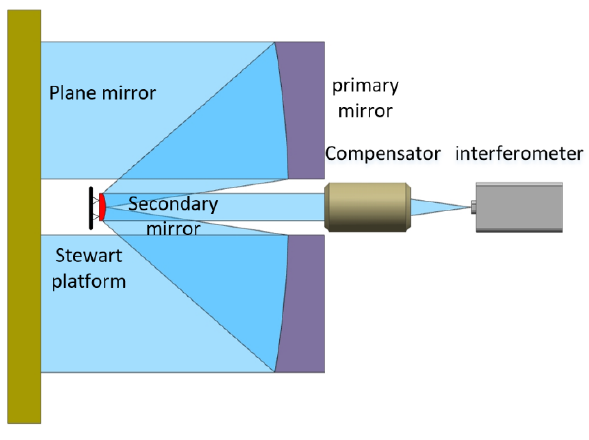
Figure 14. Schematic diagram of the experiment setup.